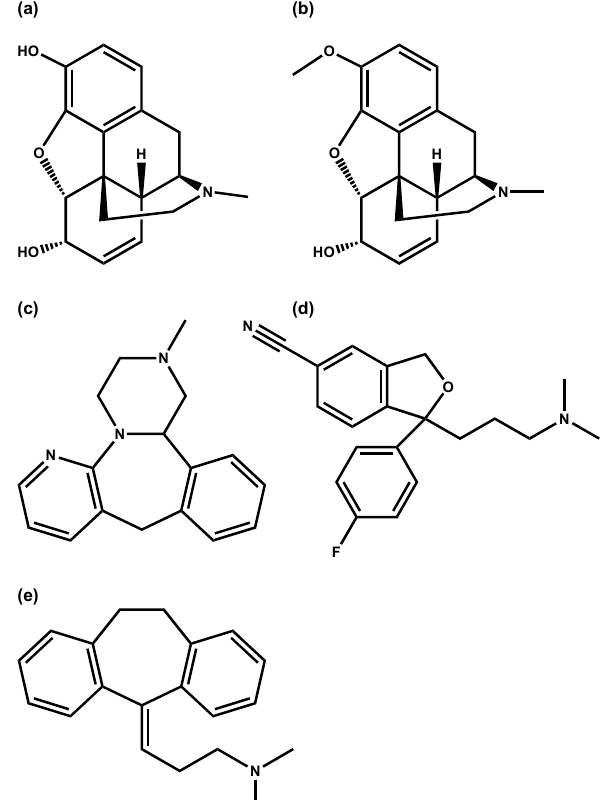
Figure 3. Chemical structures of ( a ) morphine, ( b ) codeine, ( c ) mirtazapine, ( d ) citalopram and ( e ) amitriptyline.